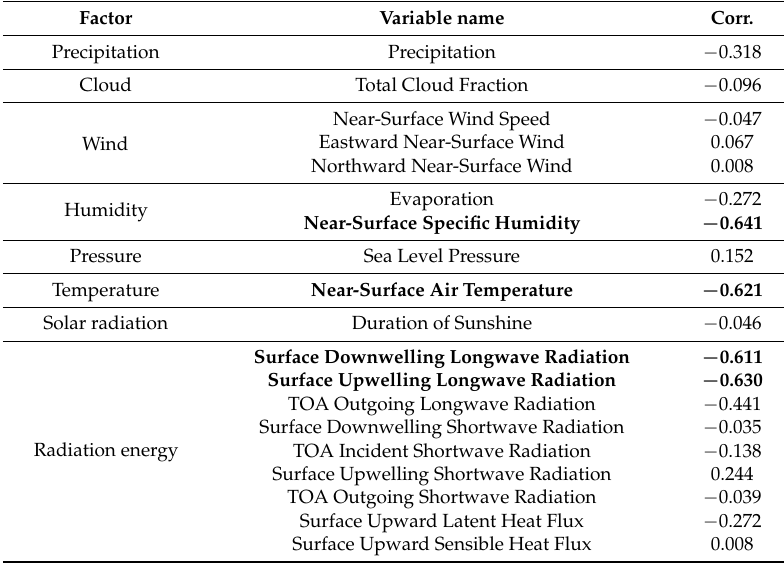
Table 3. Correlation coefficients between sea ice concentration and climate